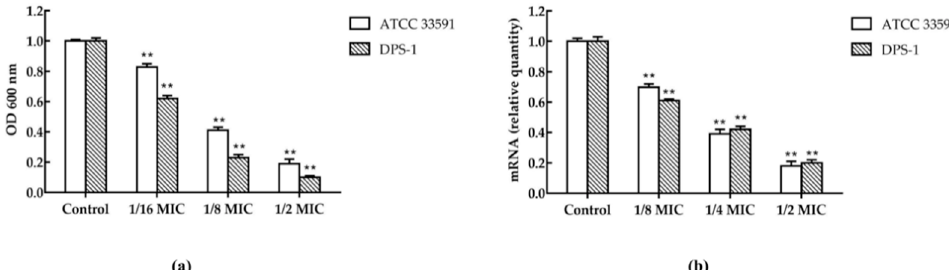
Figure 4. ( a ) Inhibition of TCA at sub-inhibitory concentrations on MRSA (ATCC 33591 and DPS-1) biofilm. ( b ) The expression of hld in MRSA (ATCC 33591 and DPS-1) cultures in the presence of TCA at various concentrations. The data were presented as the mean ± standard deviation of the three independent experiments. ** represents p <